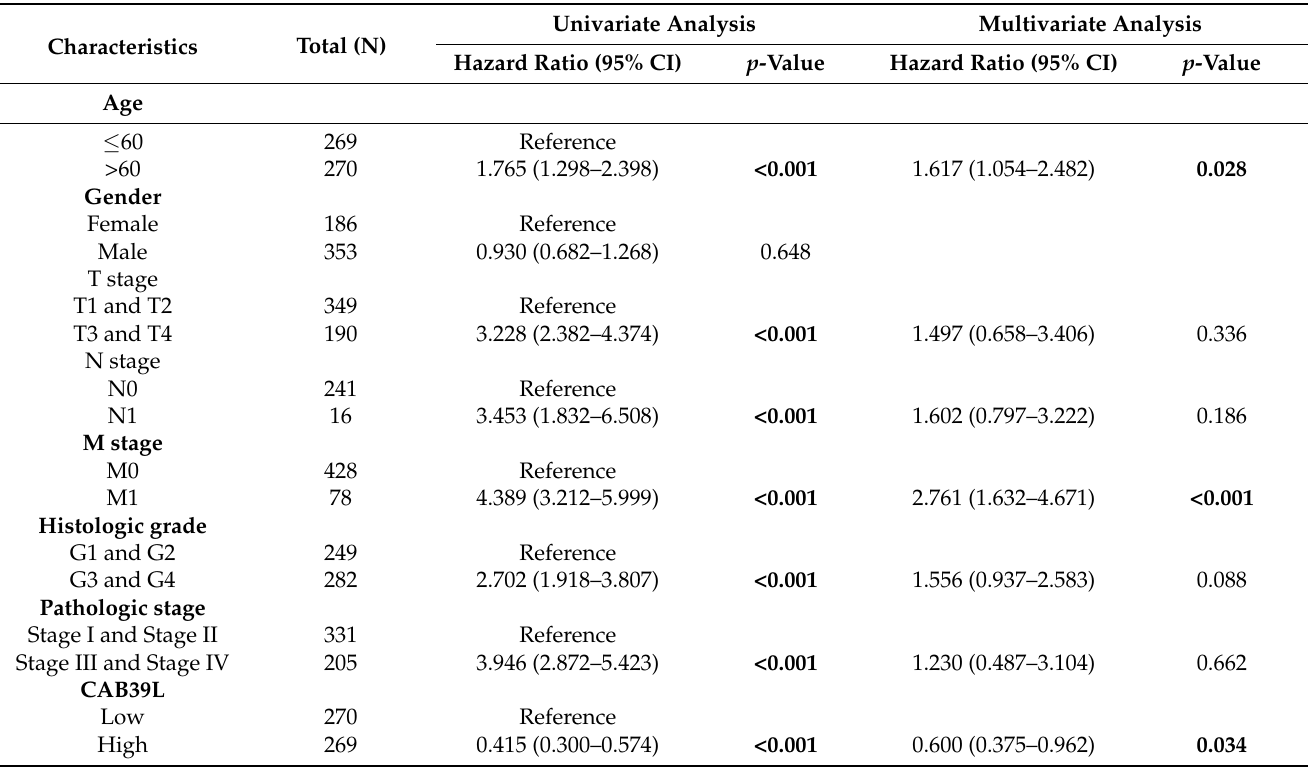
Table 3. Cox regression analysis of variables for OS in KIRC